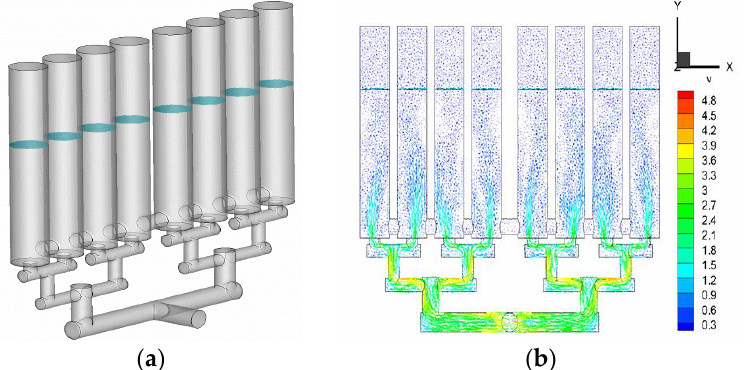
Figure 13. Hydrodynamic characteristics of the equal inertial pipeline filling–emptying system under the condition of a 150 m lifting height: ( a ) the diagram of the vertical shaft water level and ( b ) longitudinal profile velocity.